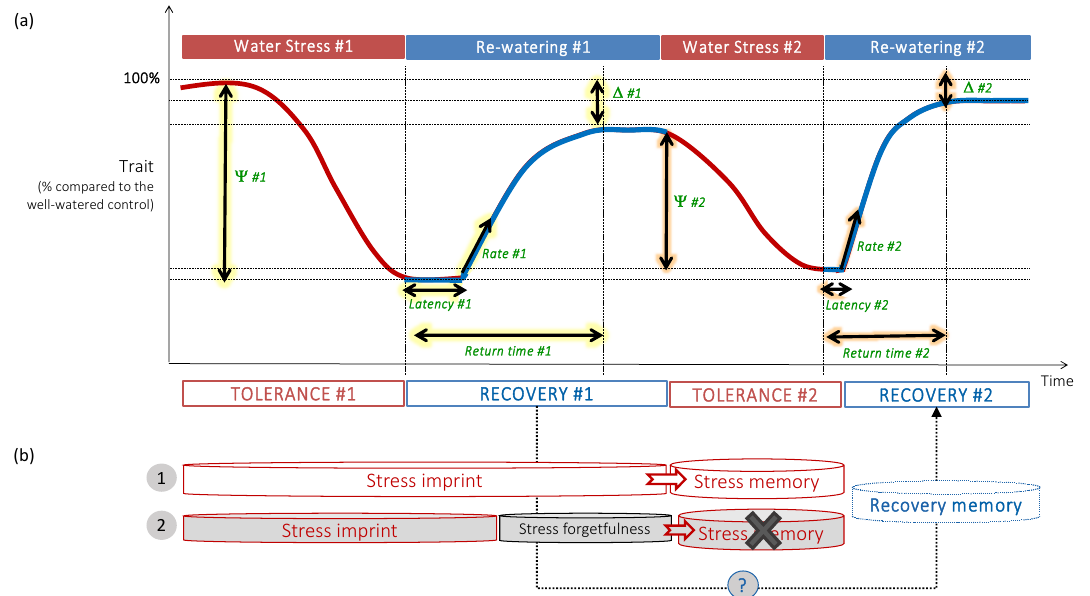
Figure 3. Conceptual framework of plant water stress memory and putative recovery memory. ( a ) A first stress ( #1 ) induces the decrease of a value of a trait with a given intensity ( Ψ #1 ) and its recovery during rewatering until plateauing. During a subsequent water stress ( #2 ), the intensity decrease ( Ψ #2 ) may be less important than during the first stress. During each re-watering period, the recovery capacity may be characterized by different variables (in green): recovery initiation latency, recovery rate, return time to plateau, and delta ( ∆ , the difference in trait value at the plateau between well-watered plants and those under water stress). During the second recovery, the trait value increase may be closer to the control value ( ∆ #2 ) than after the first recovery ( ∆ #1 ), implying a putative recovery memory process. ( b ) A stress memory can be established when the stress imprint is stored until the beginning of the second water deficit period (case 1). A stress memory cannot occur when the stress imprint is followed by memory resetting (stress forgetfulness) such as in case 2.